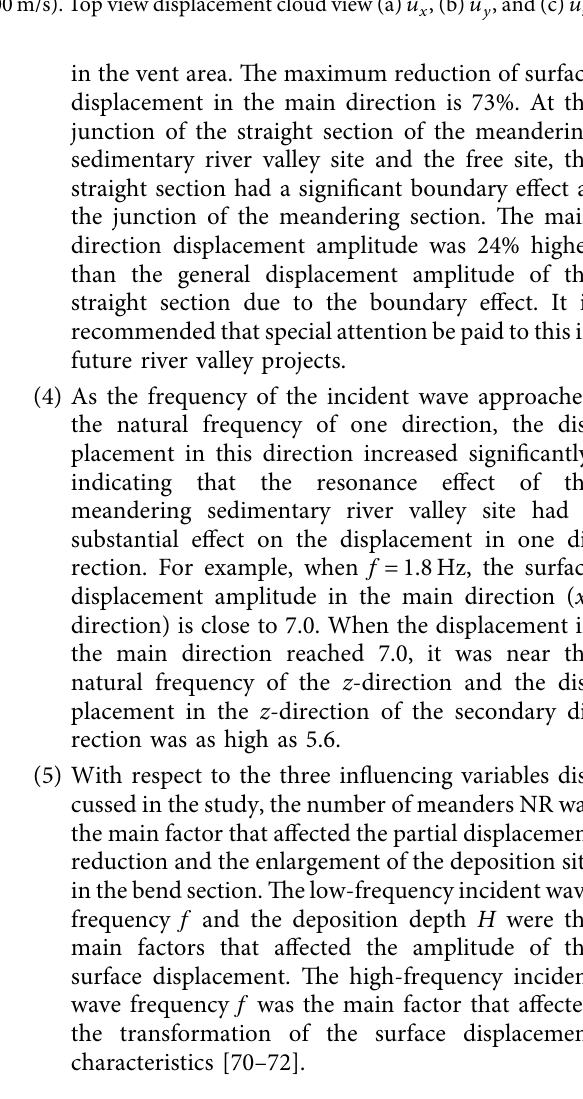
u u x , (b) y , and (c) z